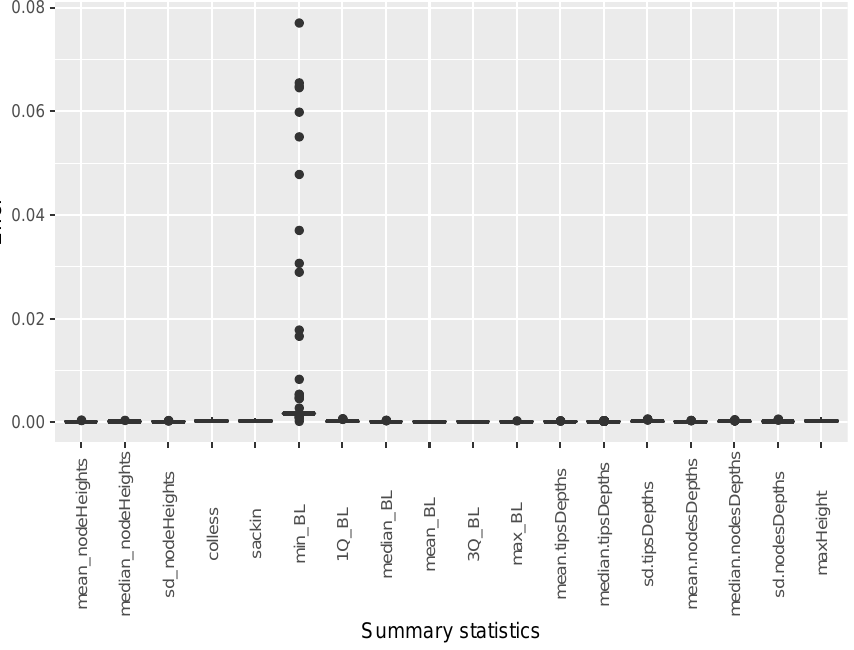
Figure A3. Relative error between mean the value of the benchmark phylogenetic tree’s summary features and those associated to retained parameter values during